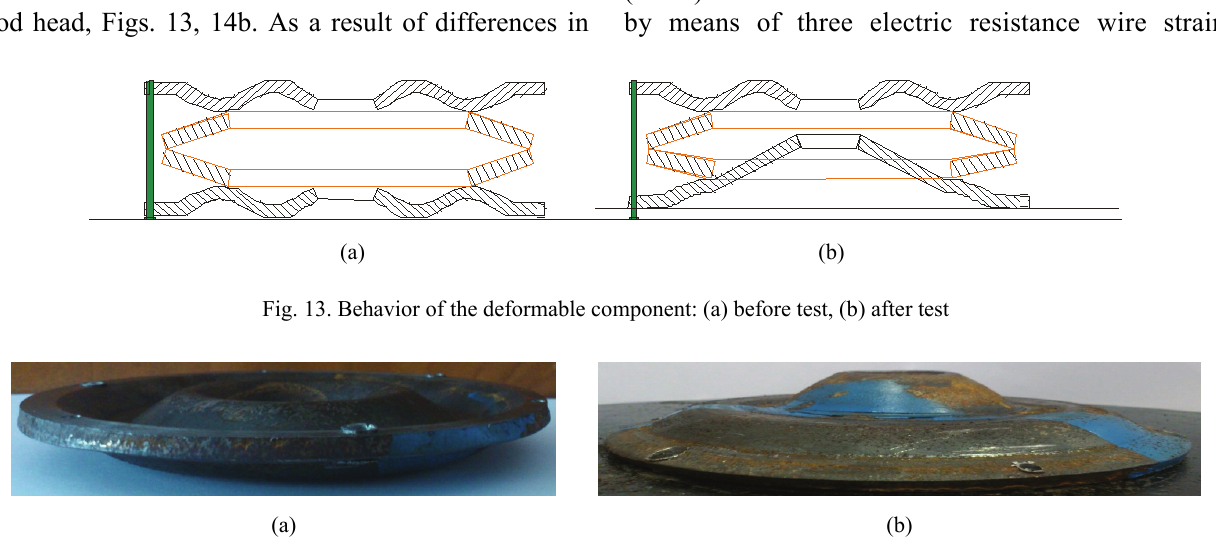
Fig. 14. The rock bolt washer used in the deformable component: (a) before test, (b), after